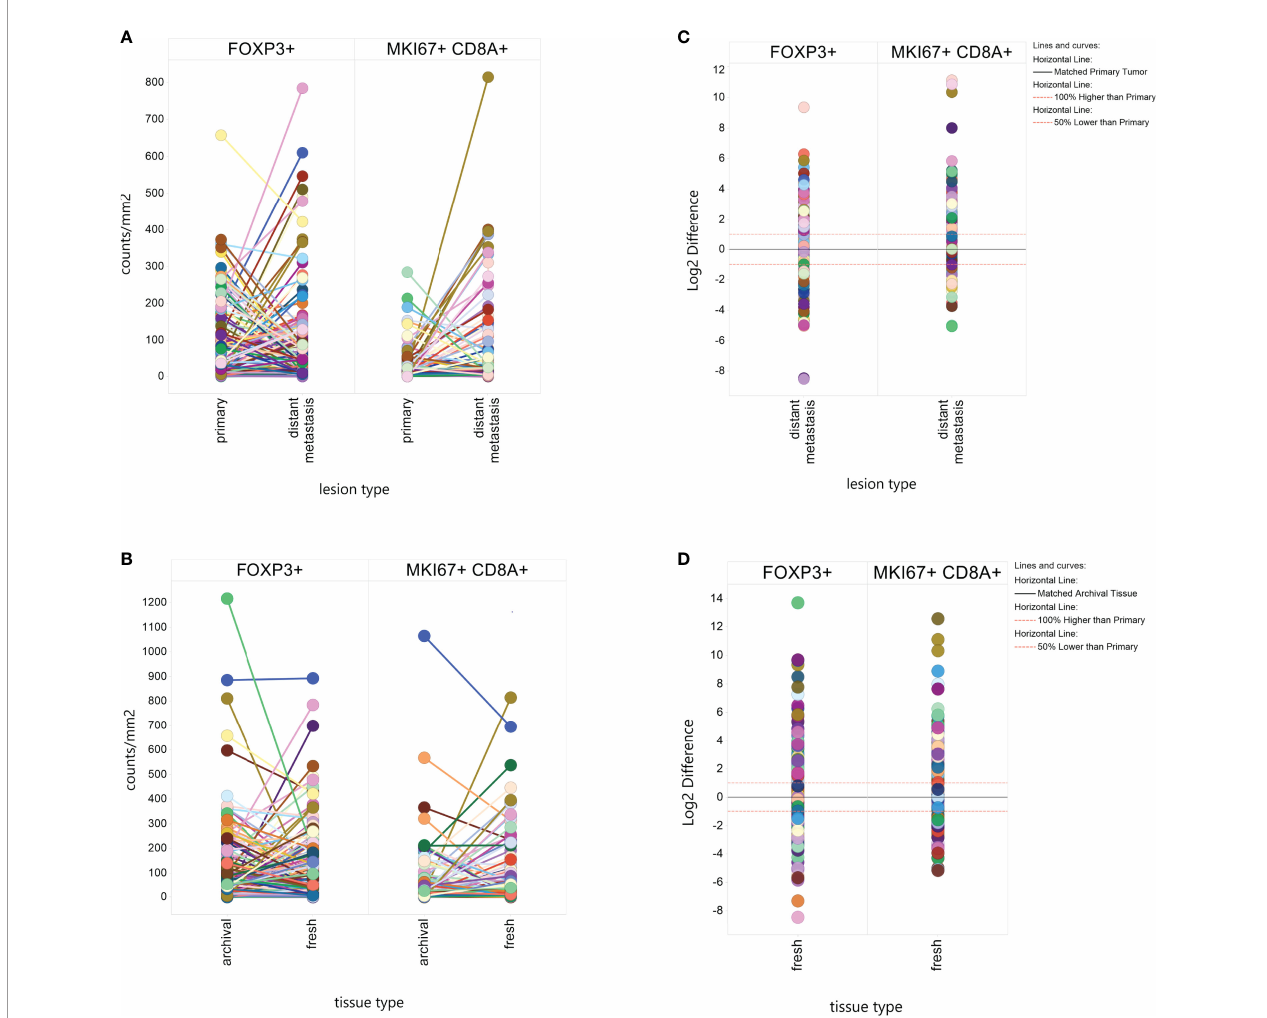
FIGURE 2 | Within Patient Heterogeneity by Lesion Type and Tissue Type. Individual biomarker measurements were plotted by lesion type (A) or tissue type (B) with line connecting values from the same patient. The difference in Log2 marker level between a distant metastasis and a paired fresh metastasis or between a fresh tissue sample and an archival tissue sample was plotted to calculate what percent of matched pairs displayed a 2-fold (Log2 ≥ |1|) or greater difference by lesion type (C) or tissue type (D)